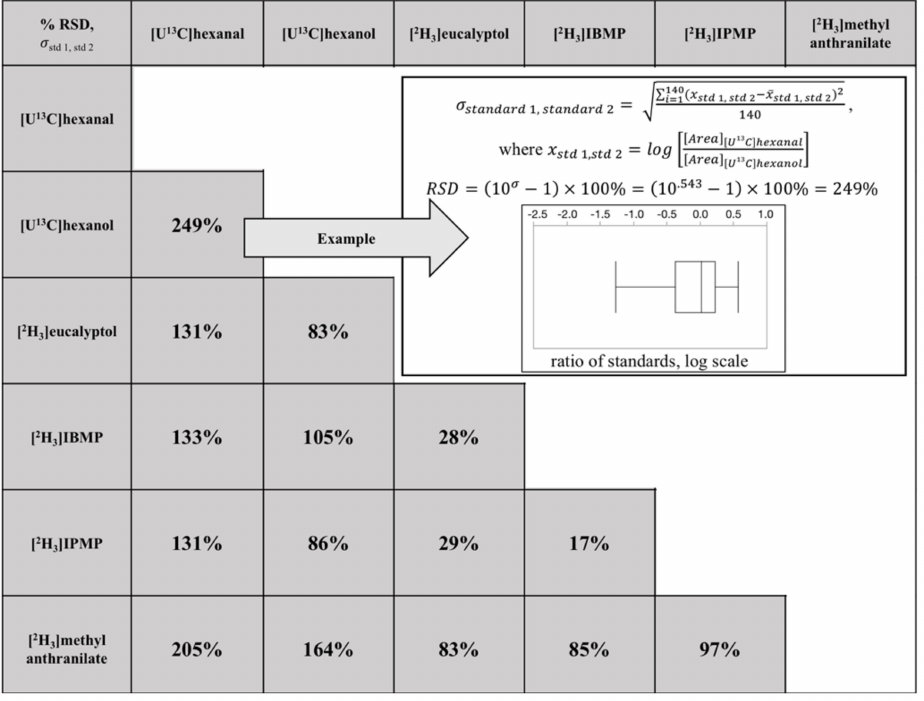
Figure 3. Compound × Individual matrix effects (%RSD) for pairs of six isotopically labeled internal standards in a grape population.